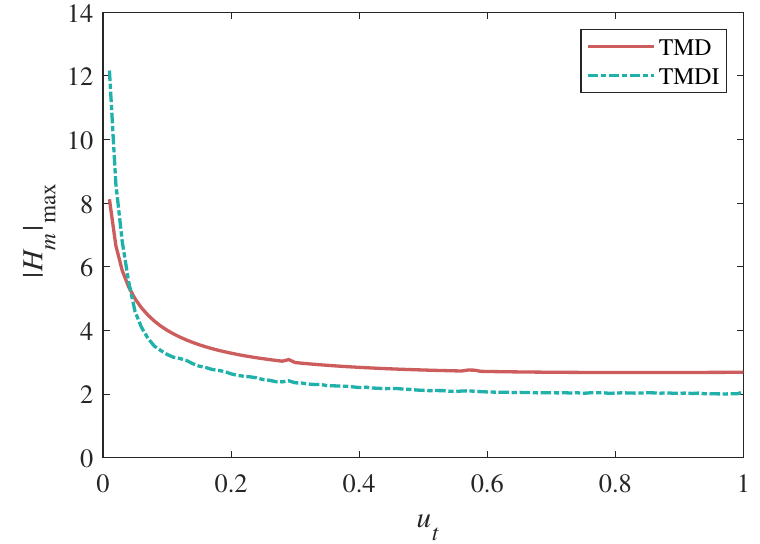
Figure 6. The maximum value of displacement TF with different mass